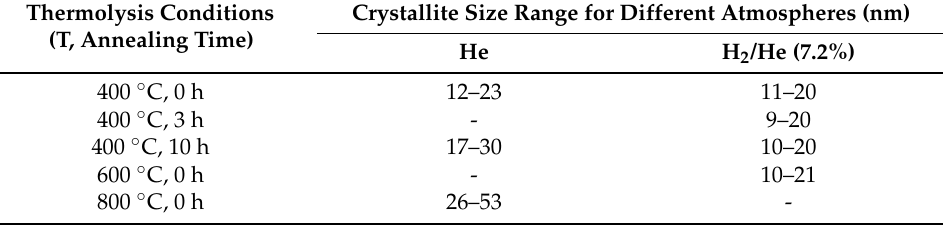
Table 6. Crystallite size of Ag nanoparticles: final products of [{Ag(µ 2 -Pz 4 )(NO 3 )} n ] (2) thermolysis under different conditions.